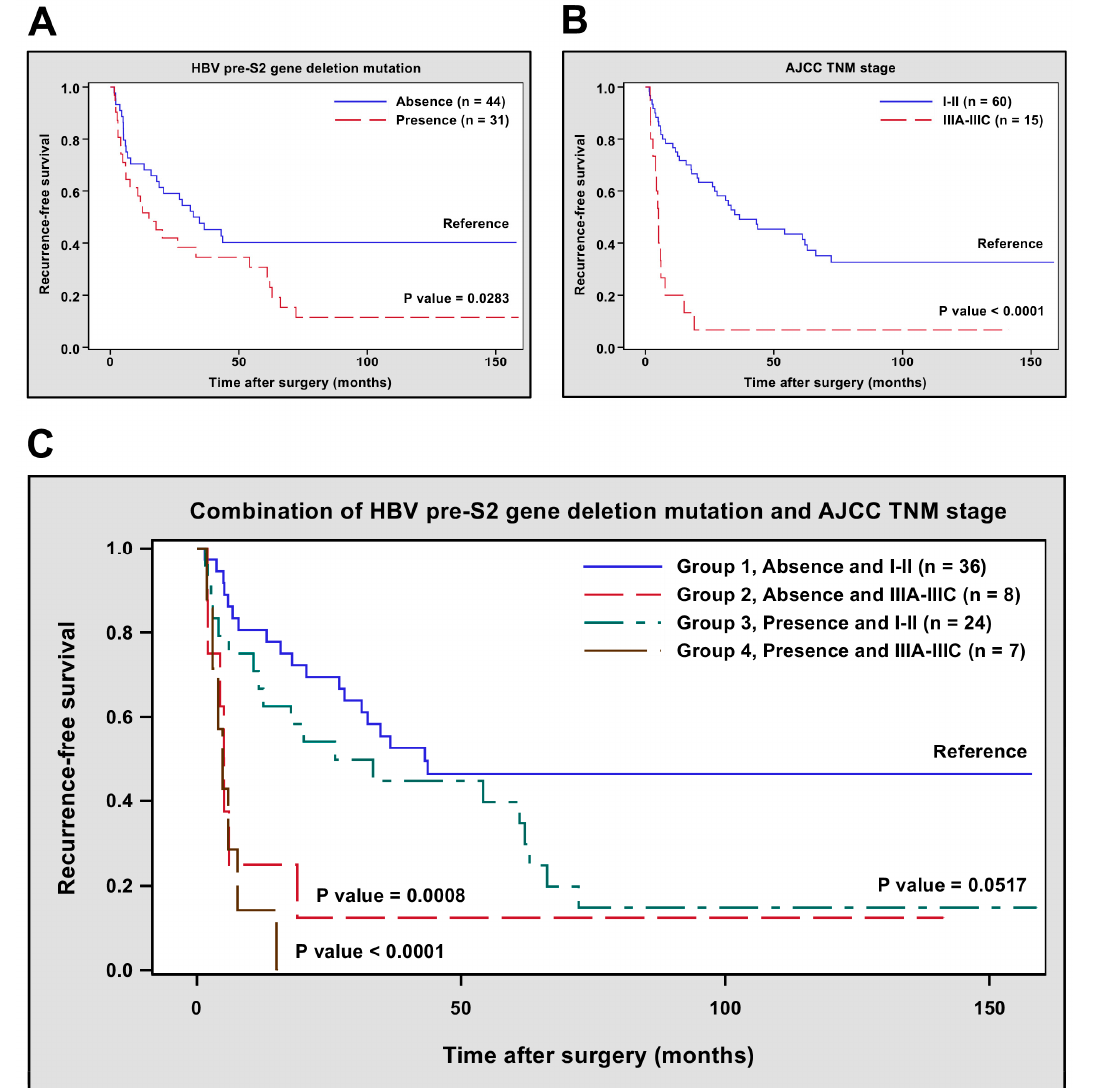
Figure 1. Kaplan-Meier curves for comparing the RFS of patients with different statuses of HBV pre-S2 gene deletion mutation and/or AJCC TNM stage after curative surgical resection. ( A ) RFS difference between patients with absence and presence of pre-S2 gene deletion mutation. ( B ) RFS difference between patients with AJCC TNM stage I–II and stage IIIA-IIIC. ( C ) RFS difference between patients with absence or presence of pre-S2 gene deletion mutation in combination with AJCC TNM stage I–II or stage IIIA-IIIC.